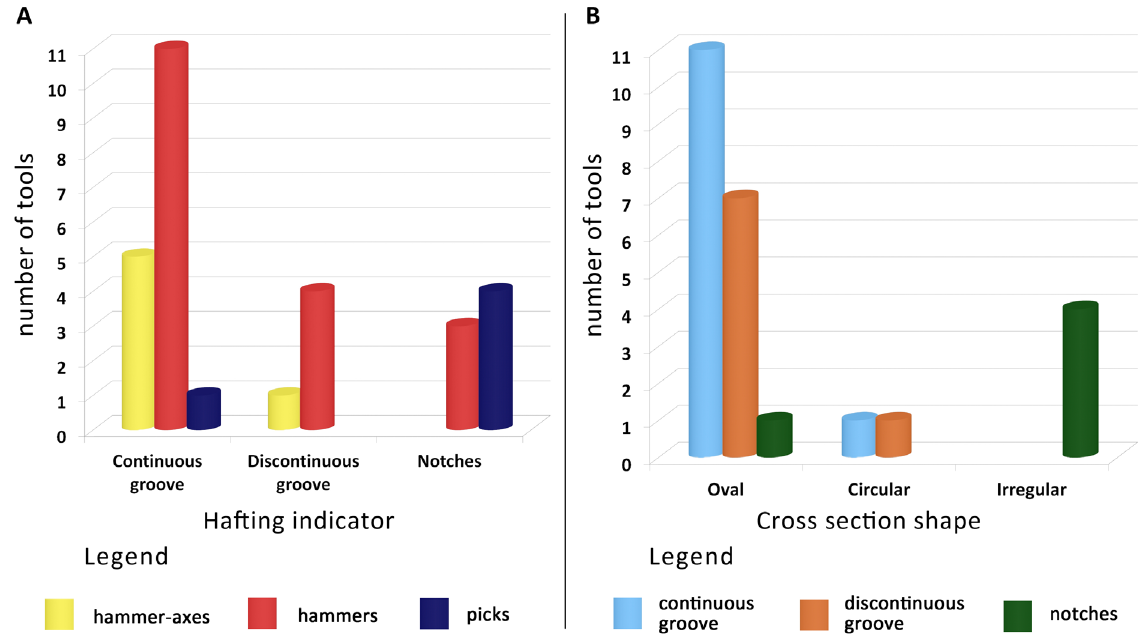
Figure 8: a. Relation between hafting modification and typological classes; b. Relation between cross-section shape and hafting